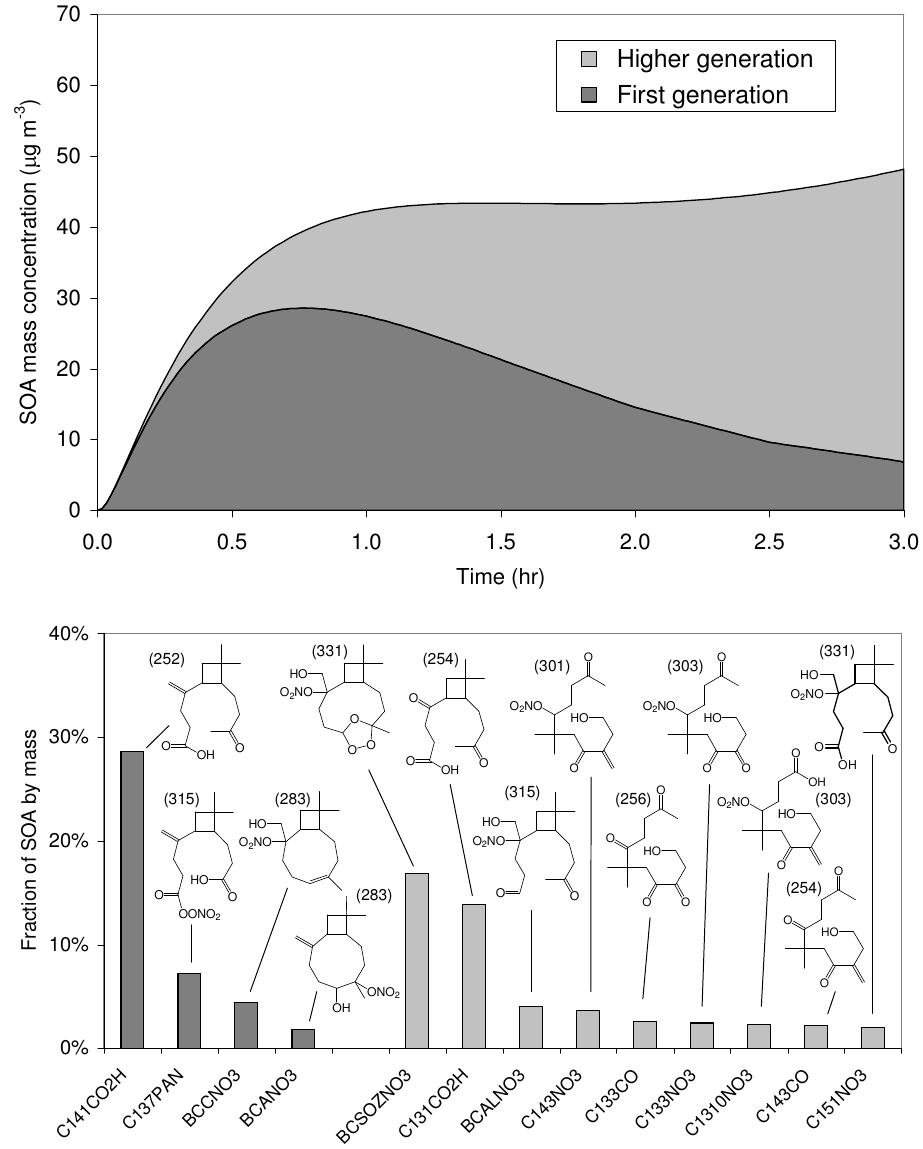
Fig. 21. Simulated SOA composition for ACES photo-oxidation experiment 03-07-08, using the MCM v3.2 scheme, with a 6% yield of OH (and co-radicals) from β -caryophyllene ozonolysis. The upper panel shows the simulated time dependence of the contributions of first and higher generation products to SOA. The lower panel shows the contributions of the top 13 simulated contributors, averaged over the experiment, these accounting for ∼ 92% of the total simulated SOA mass loading. N.B.: C143NO3, C133NO3, C1310NO3, C133CO and C143CO have minor first-generation contributions, but are formed predominantly as higher generation products. The displayed values indicate the molecular masses of the products.